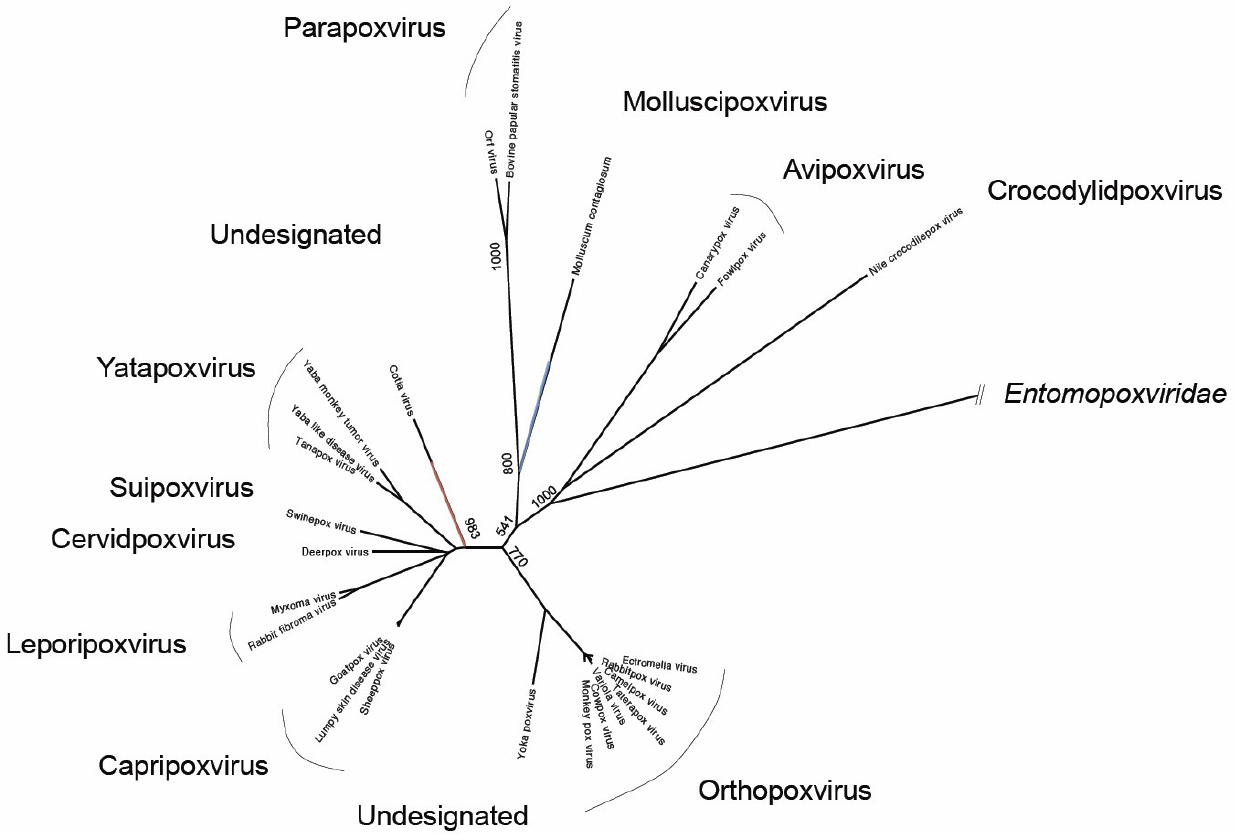
protein of Poxviridae (please see Table S2 in Supplementary files). The